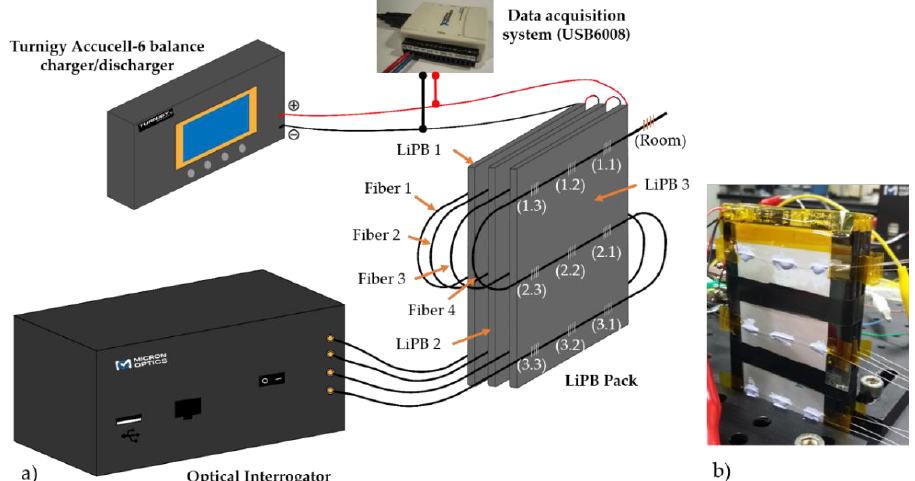
Figure 2. ( a ) Experimental setup of the sensing network with the FBG sensor positions used to monitor the LiPBs pack. ( b ) Photograph of the LiPBs pack instrumented with the fiber sensing